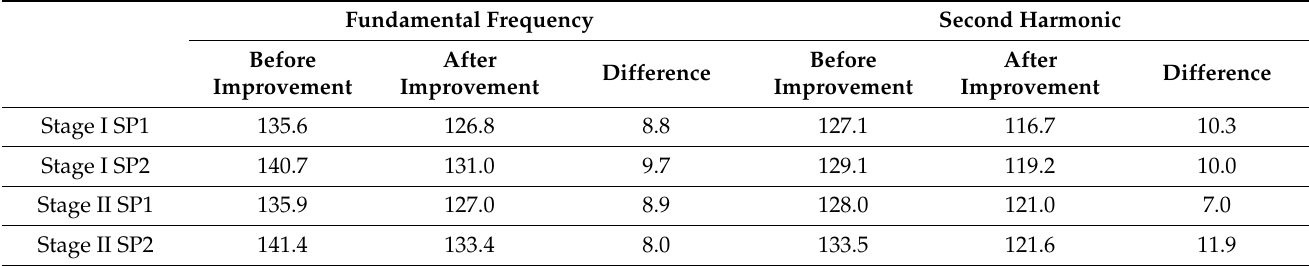
Table 8. Noise at rotating fundamental frequency and second harmonic at common condition [dBA].